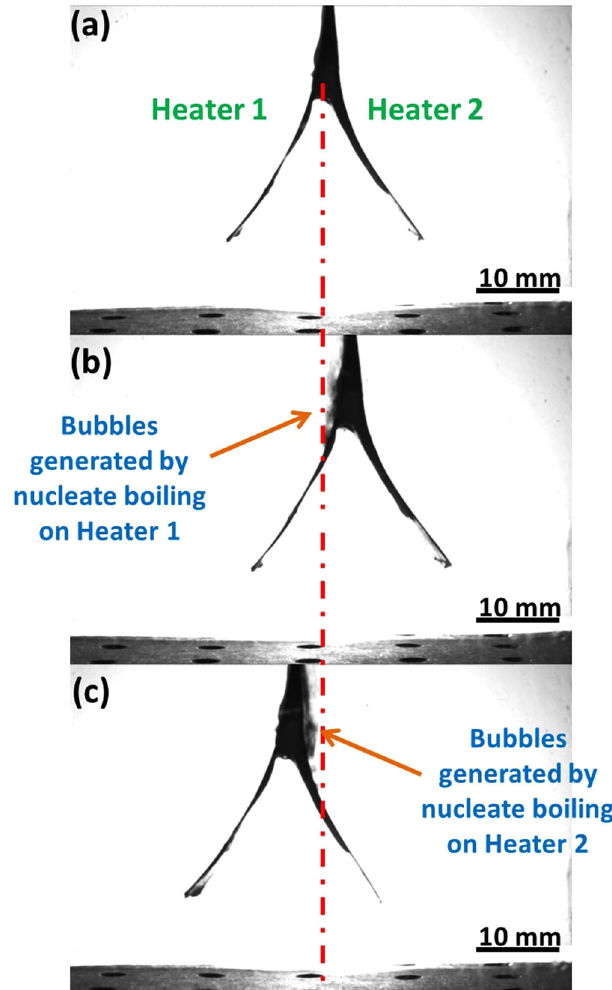
Fig. 3 The alternating nucleate boiling on the concave sides of the two heaters in the assembly resulting in a swing-like motion driven by the alternating vapor recoil force. a The initial position. b Swing to the right, when the left-hand side heater (Heater 1) is operated, with the vapor recoil force propelling the assembly to the right. c Swing to the left, when the right-hand side heater (Heater 2) is operated, with the vapor recoil force propelling the assembly to the left